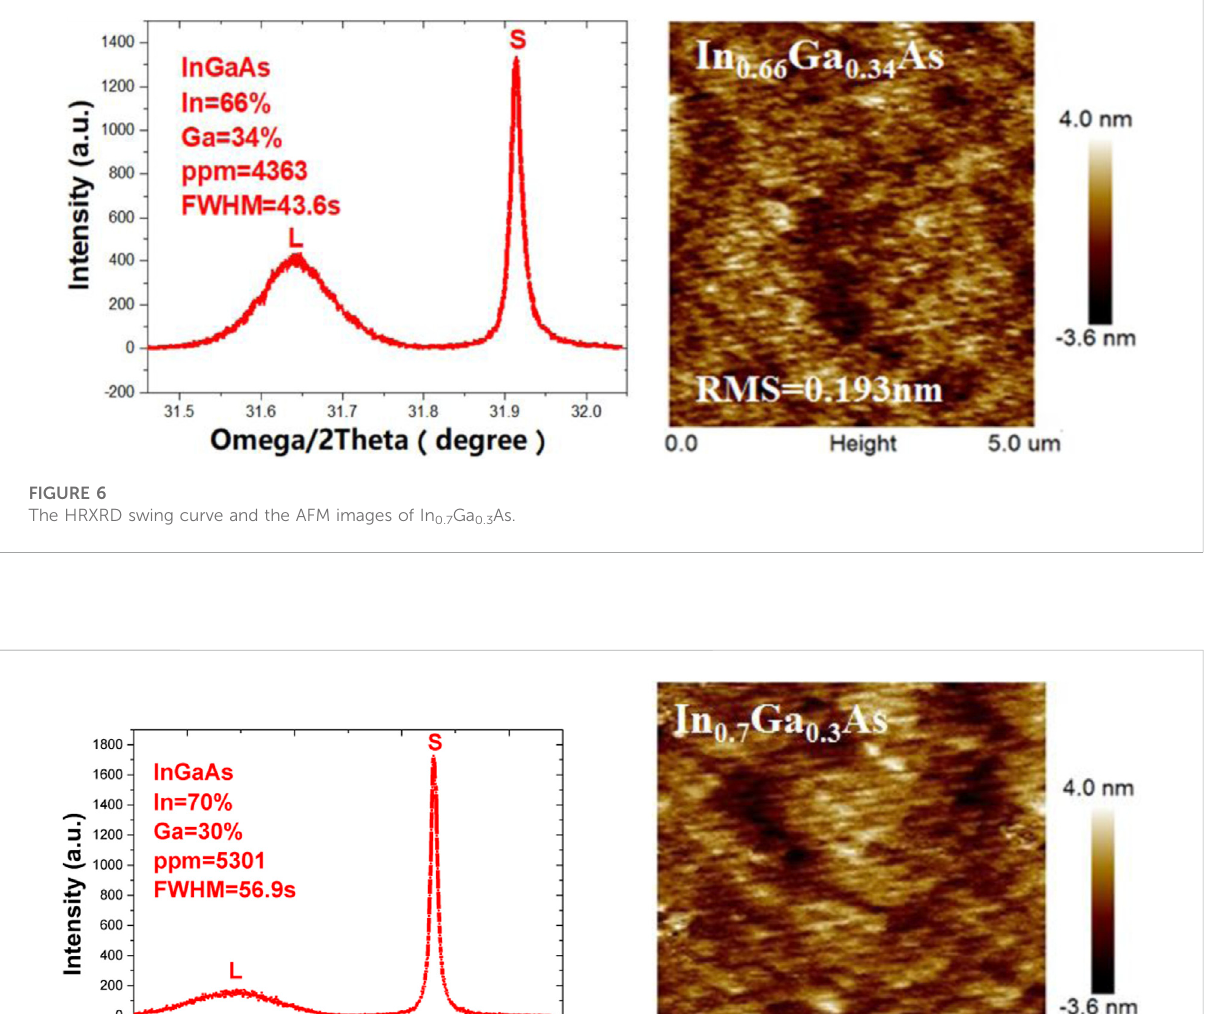
FIGURE 7 The HRXRD swing curve and the AFM images of In 0.7 Ga 0.3 As.